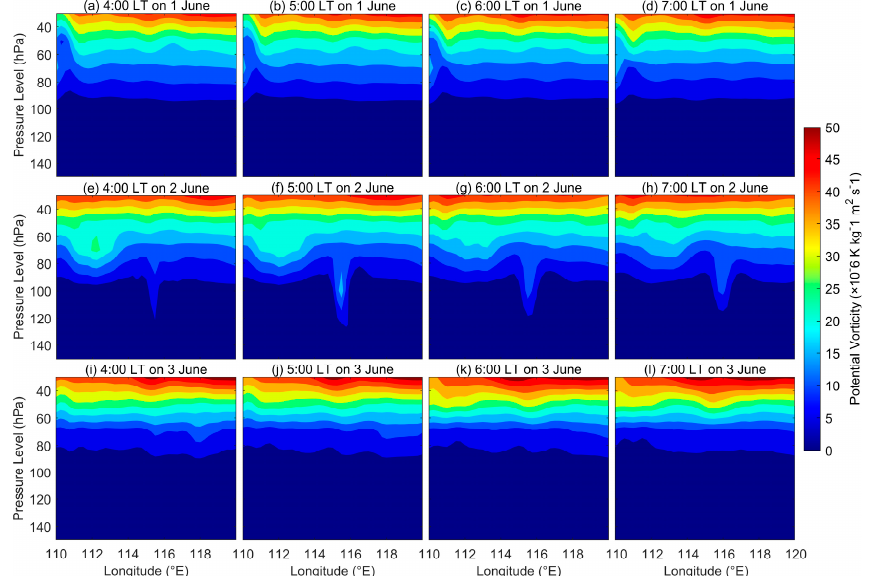
Figure 11. Potential vorticity (PV) in the warp direction (ERA 5 data). The data at 4:00–7:00 LT are listed from left to right in columns, and the data on 1–3 June 2015 are listed from top to bottom in